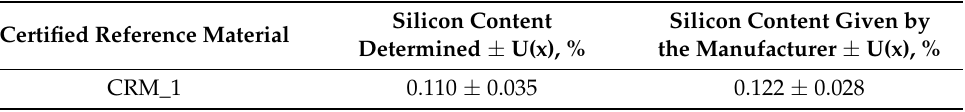
Table 4. Silicon content with expanded uncertainty for certified reference